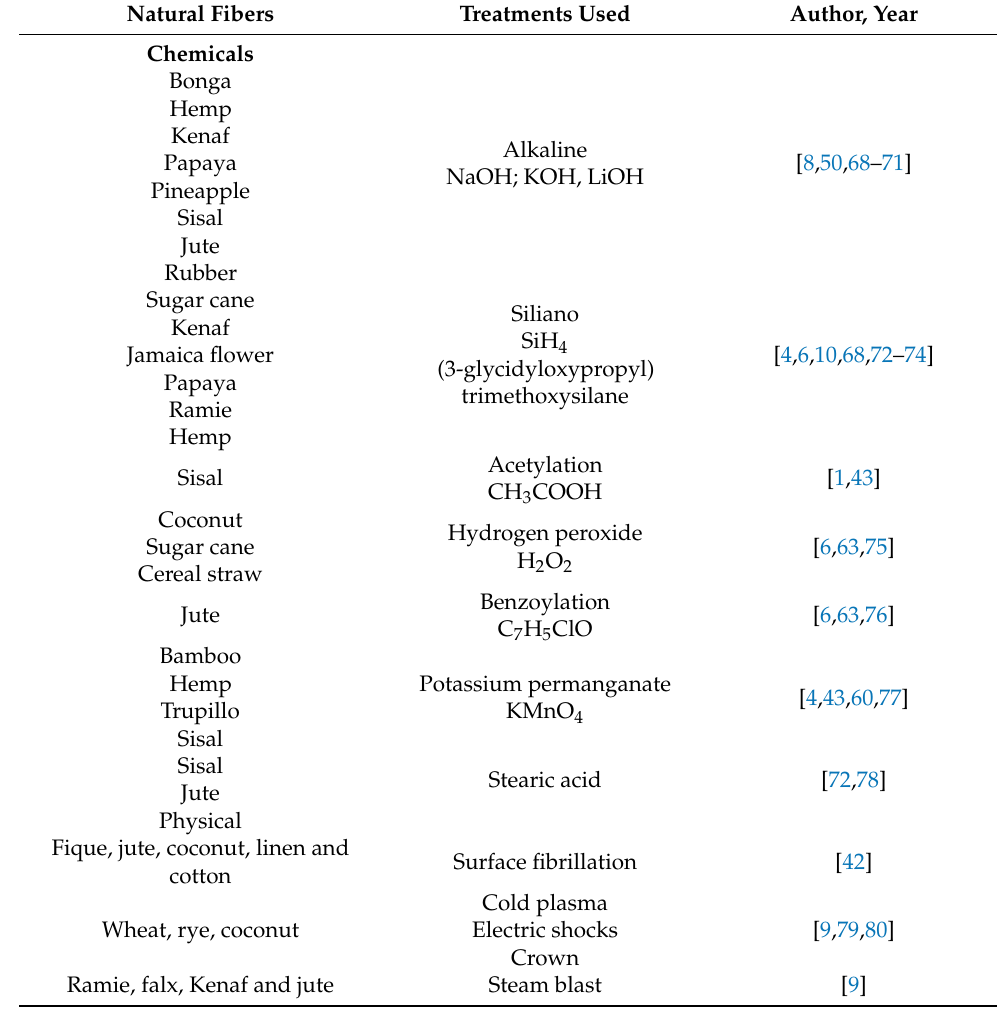
Table 4. Common chemical and physical treatments used on natural fibers. Natural Fibers Treatments Used Author,